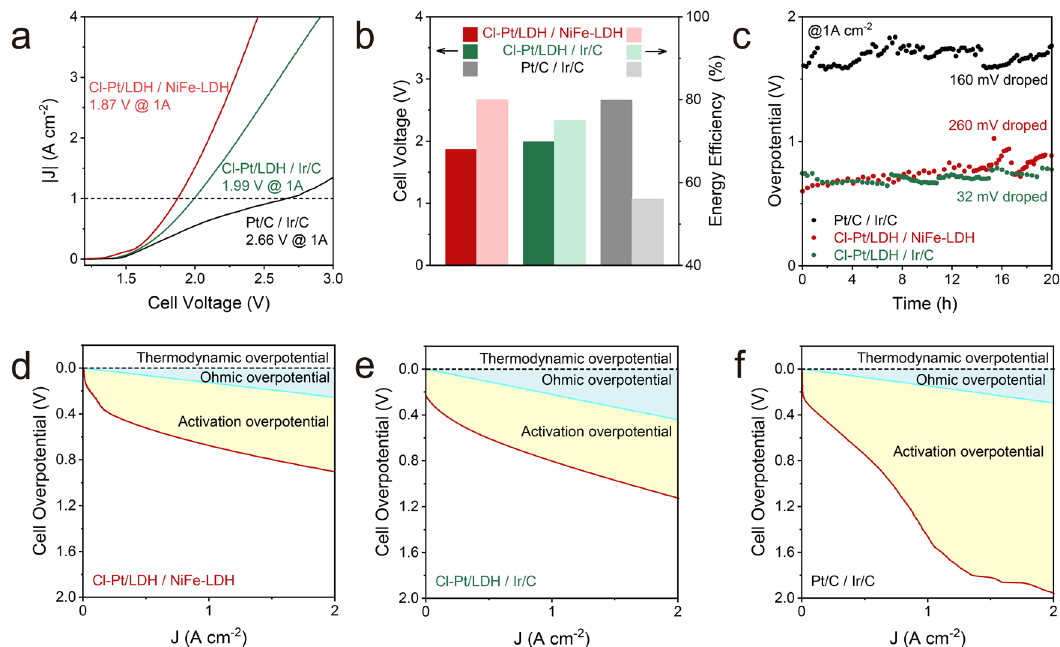
Fig. 5 | Alkaline HER in the MEA electrolyser. a LSV curves of the MEA reactors using Cl-Pt/LDH / NiFe-LDH, Cl-Pt/LDH / Ir/C, and commercial Pt/C / Ir/C as the cathodic and anodic electrodes, respectively. b Cell voltage at current density of 1Acm − 2 in Fig. 5a, and the corresponding energy ef fi ciency. c Stability tests of the